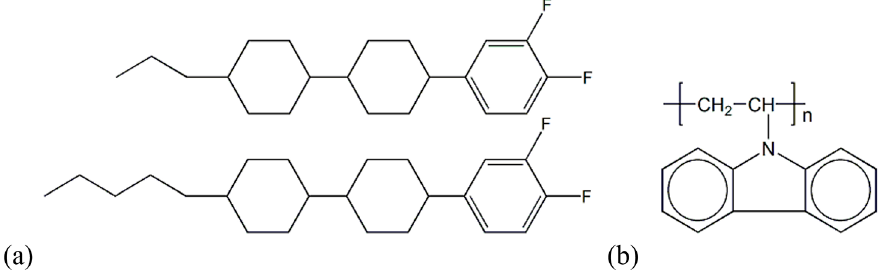
Figure 1. Chemical structures of materials used in the present work: ( a ) LCs (TL205) and ( b ) photoconductive polymer (PVK).